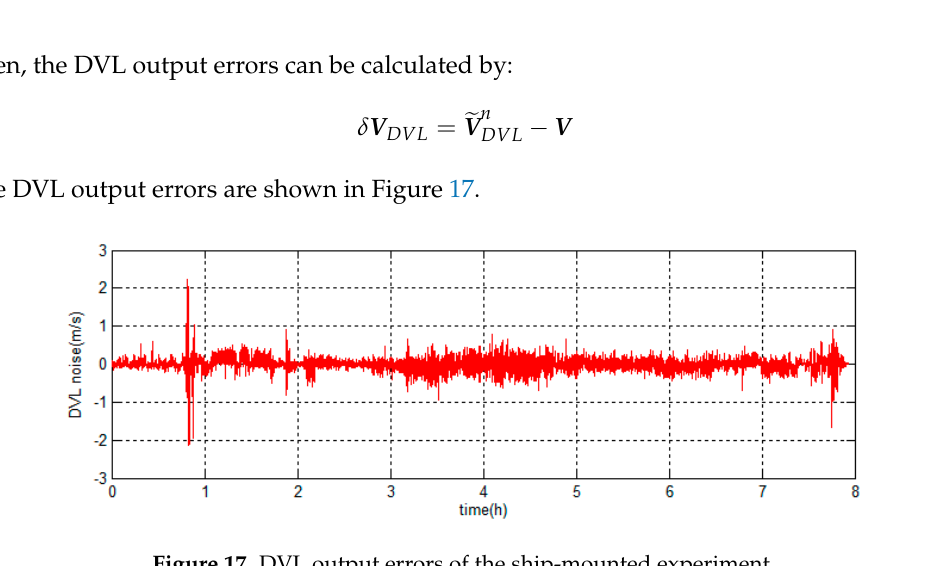
Figure 16. The ship trajectory of the ship-mounted experiment.